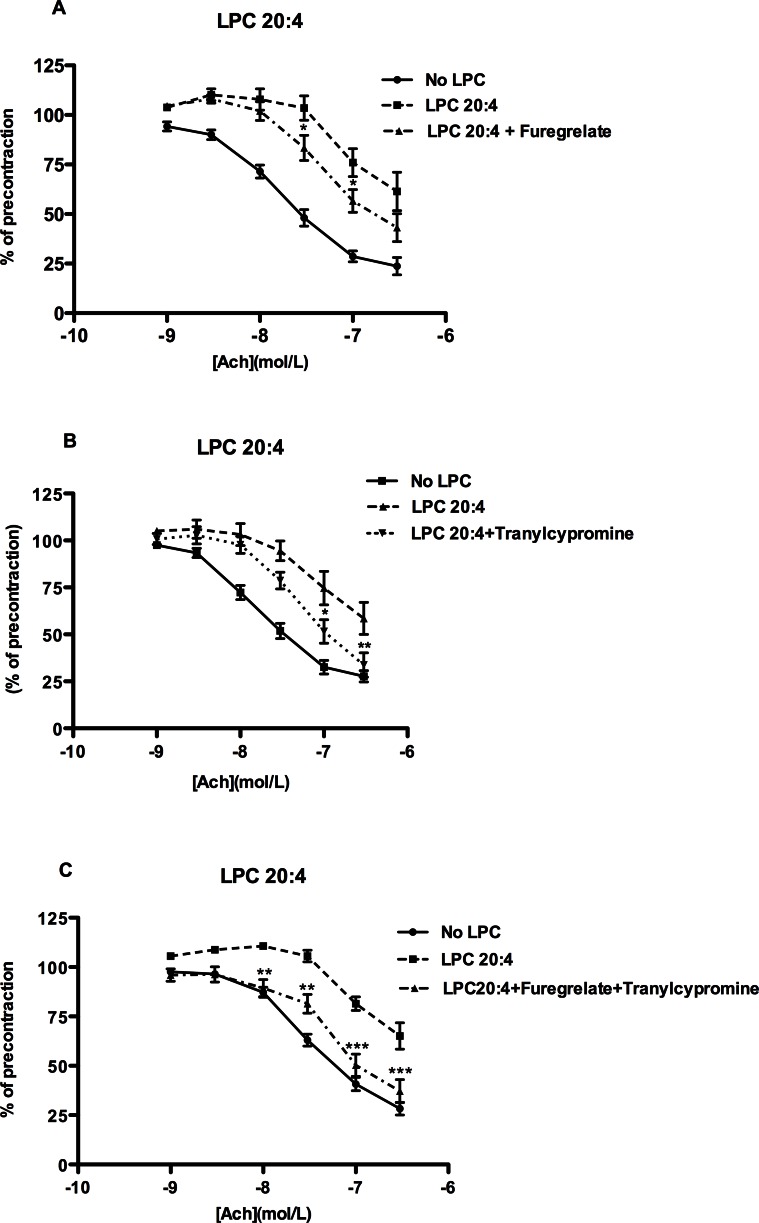
Inhibition of TXA2- and PGI2- synthase improves relaxation attenuated by LPC 20:4.The rings were preincubated without (no LPC) or with LPC 20:4 in the absence or presence of 10 µM furegrelate, a TXA2 synthase inhibitor (A) or 10 µM tranylcypromine, a PGI2 synthase inhibitor (B) or a combination of both (C) for 30 minutes, followed by precontraction with NE and cumulative addition of ACh. Results are mean ± SEM of 12 rings from 6 mice. *P<0.05, **P<0.01.